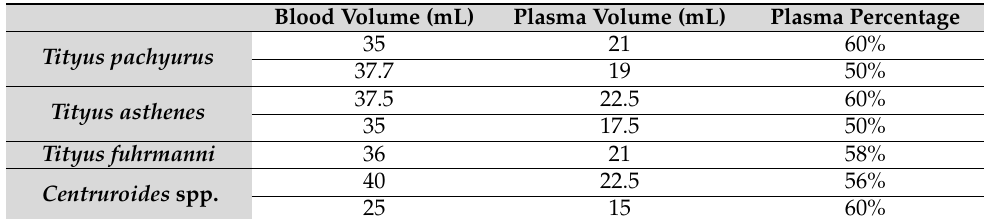
Figure 2. Immunization timeline. Rabbit immunization period using different antigen mixture amounts according to each LD 50 . Samples to determine antibody titers were collected 8 days after the immunization (+8 d) on t0, t2, t3, t4, t5, and t6; t0 was used as baseline or control. Bleeding was performed on t6. Table 2. Collected blood volume and plasma quantification.